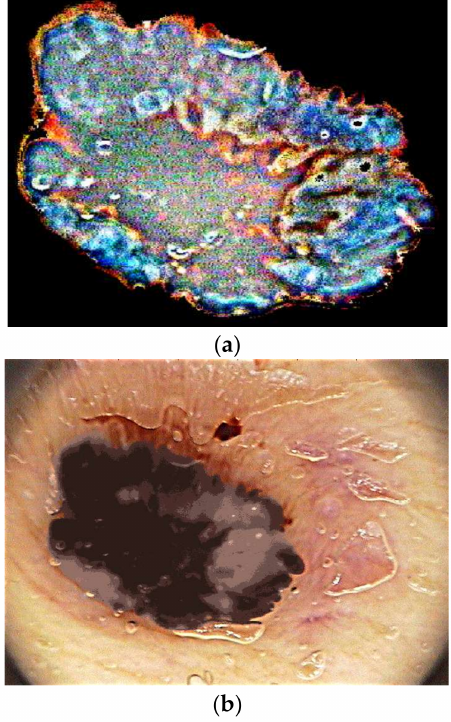
Figure 6. ( a ) Dyschromia image obtained considering the image segmented in coherent color areas. ( b ) Corresponding flattened